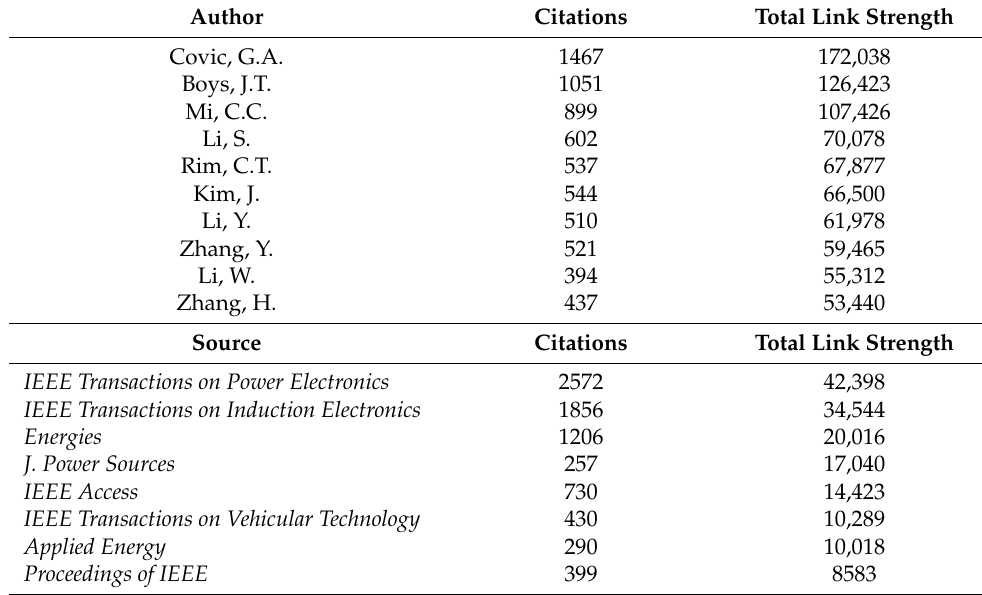
Figure 8. Co-citation analysis for authors. Network ( A ) and density visualization ( B ) showed 1170 out of 38,915 authors that met the minimum citation count of 20 per author. The maps consist of 1170 items, 7 clusters, and 472,247 links. Table 3. Co-citation Analysis: Top Cited Authors and Sources based on Total Link Strength.